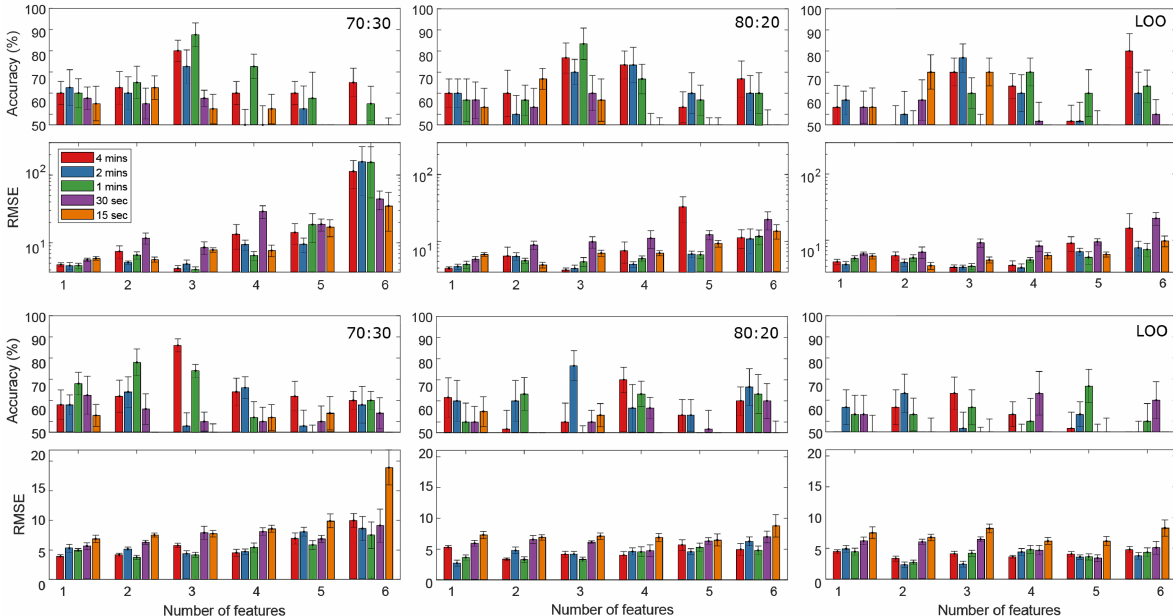
Figure 7. Average classification accuracy and RMSE for the EEG ( top row) and NR-EEG models ( bottom row), for the six most significant features. Accuracy and RMSE were calculated using different amount of data from the AO task (4 min to 15 s). Error bars represent standard error across cross-validations. Model performance was evaluated using 70:30 ( left ), 80:20 ( middle ) and LOO ( right ) data splitting